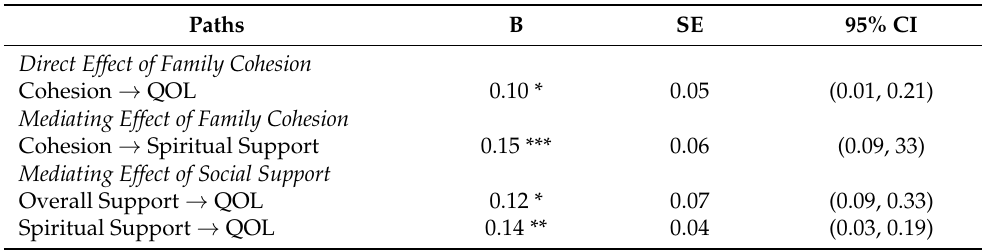
Table 2. Direct and indirect effects of family cohesion and spiritual support on